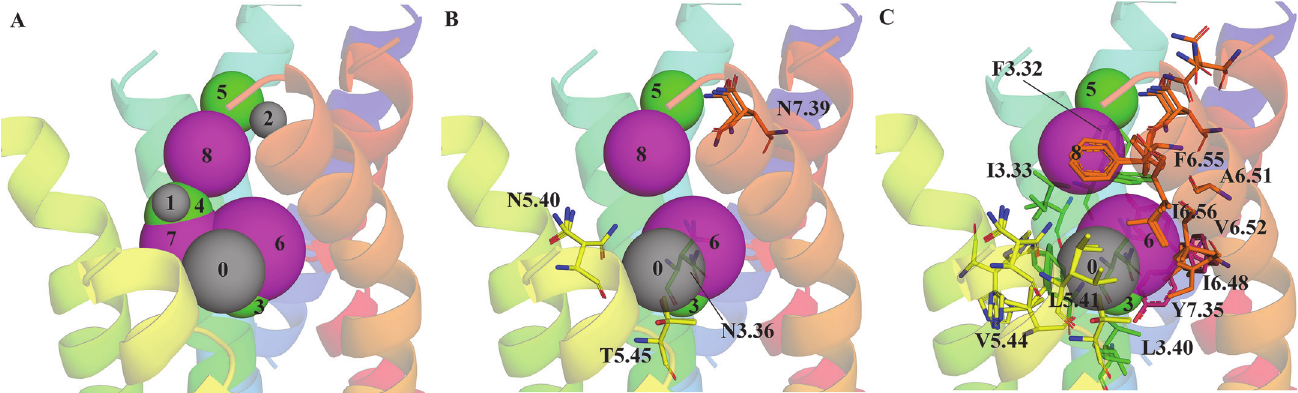
Fig 1. Homology model of the TM domains of hTAS2R39. TM I is depicted in dark blue, TM II in light blue, TM III in cyan, TM IV in light green, TM V in yellow, TM VI in orange, and TM VII in red. A) The Snooker pharmacophore hypothesis consists of acceptor features (numbers 0 , 1 , and 2 in gray), donor features (numbers 3 , 4 , and 5 in green), and hydrophobic features (numbers 6 , 7 , and 8 in magenta). Residues contributing to B) acceptor and donor features ( 0 , 3 , and 5 ) and C) hydrophobic features ( 6 , and 8 ) of the best performing feature combination are shown as sticks. All common rotamers are shown.